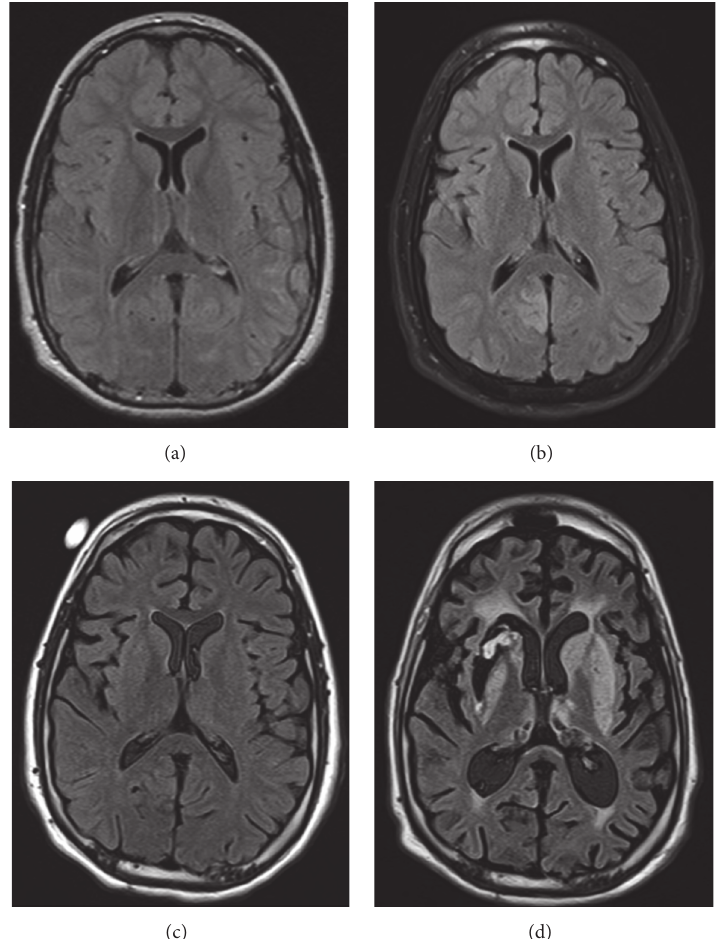
Figure 1: Serial brain magnetic resonance imaging (MRI). Consecutive fluid attenuated inversion recovery sequences (FLAIR) of brain MRIs of the patient with super refractory status epilepticus in a medically induced coma. The serial images show development and progression of diffuse cerebral